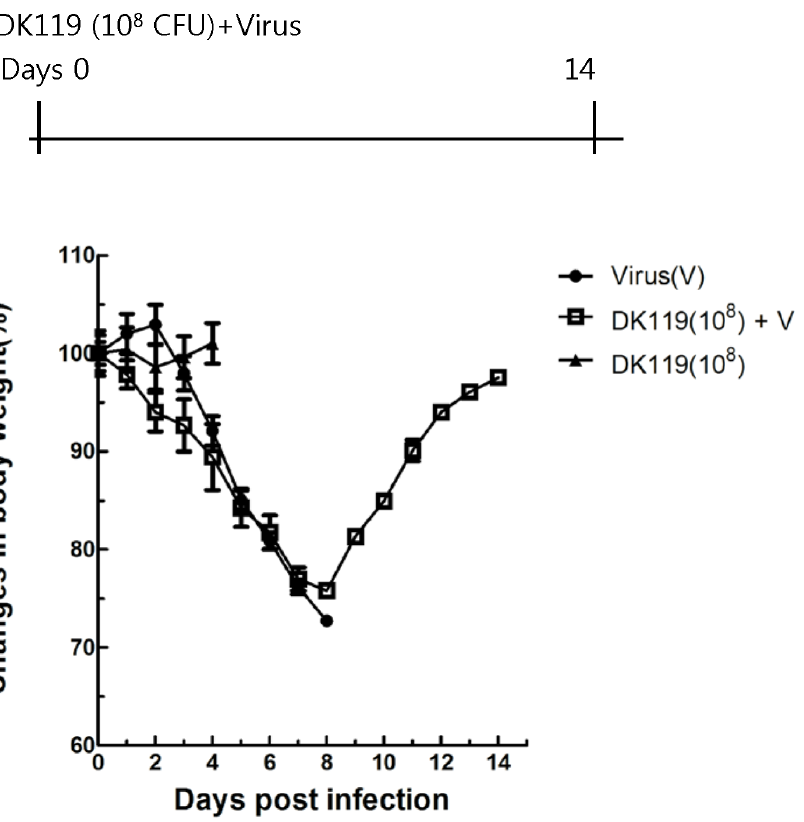
Figure 2. Intranasal co-administration of a low dose of DK119 (10 8 CFU) and A/PR8 virus (H1N1) provides survival protection. BALB/ c mice (n=6 per group) were infected once with A/PR8 virus (2.5 LD 50 ) alone or co-administered with DK119 (10 8 CFU per mouse) and A/PR8 virus, and monitored daily for 14 days. Virus(V): mice infected with A/PR8 virus, DK119 (10 8 ) + V: mice infected with DK119 and A/PR8 virus.DK119 (10 8 ): mice treated with DK119 (10 8 CFU per mouse) alone did not show weight losses.